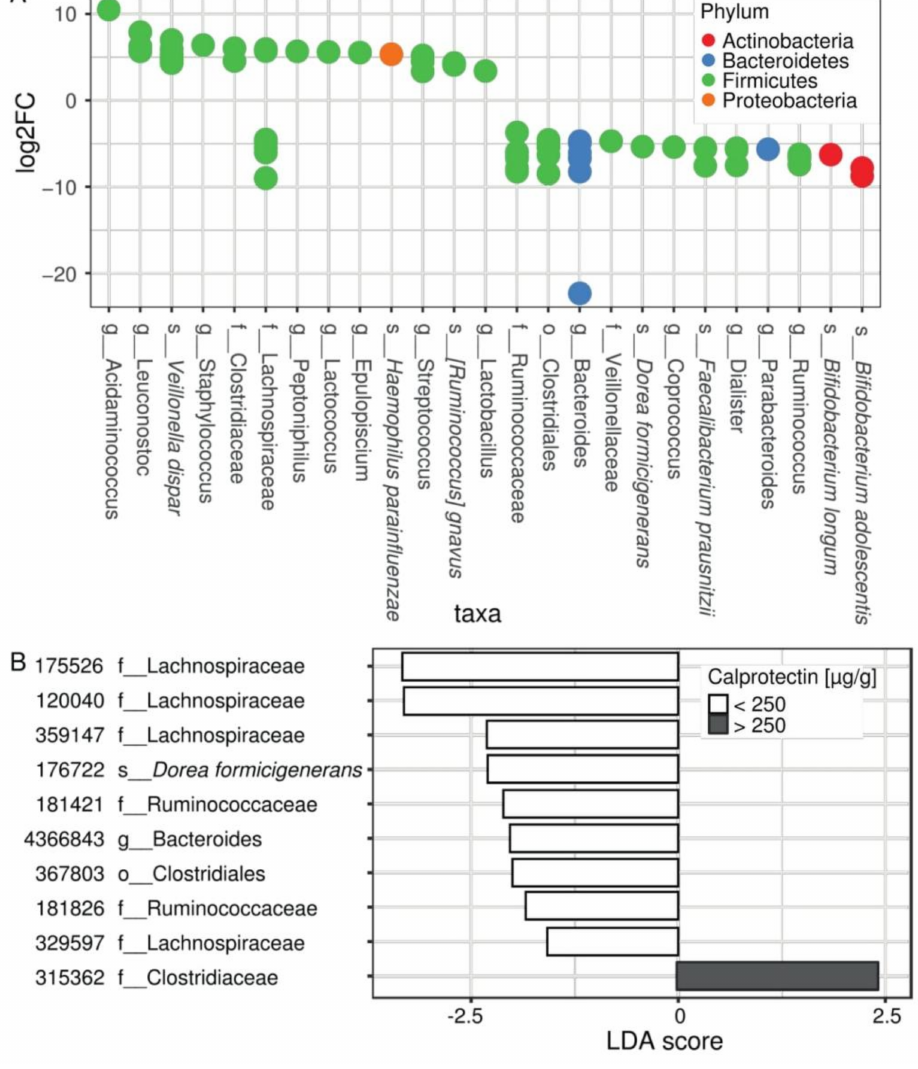
Figure 2. The composition of the microbiota di ff ers according to the inflammation status of CF patients. ( A ) Di ff erential abundance analysis (DESeq) assessing OTU significantly changed in the microbiome of patients with intestinal inflammation, compared with patients without intestinal inflammation. Each circle represents one of 80 significant OTUs colored by a phylum according to the legend. OTUs are collapsed to 25 taxa represented on x axis and ordered by decreasing log of fold change. For full results see Supplementary Table S2. ( B ) LEfSe analysis showing OTUs distinguishing patients without and with intestinal inflammation ( p -value < 0.01) and confirming DESeq2 results. For full results see Supplementary Table